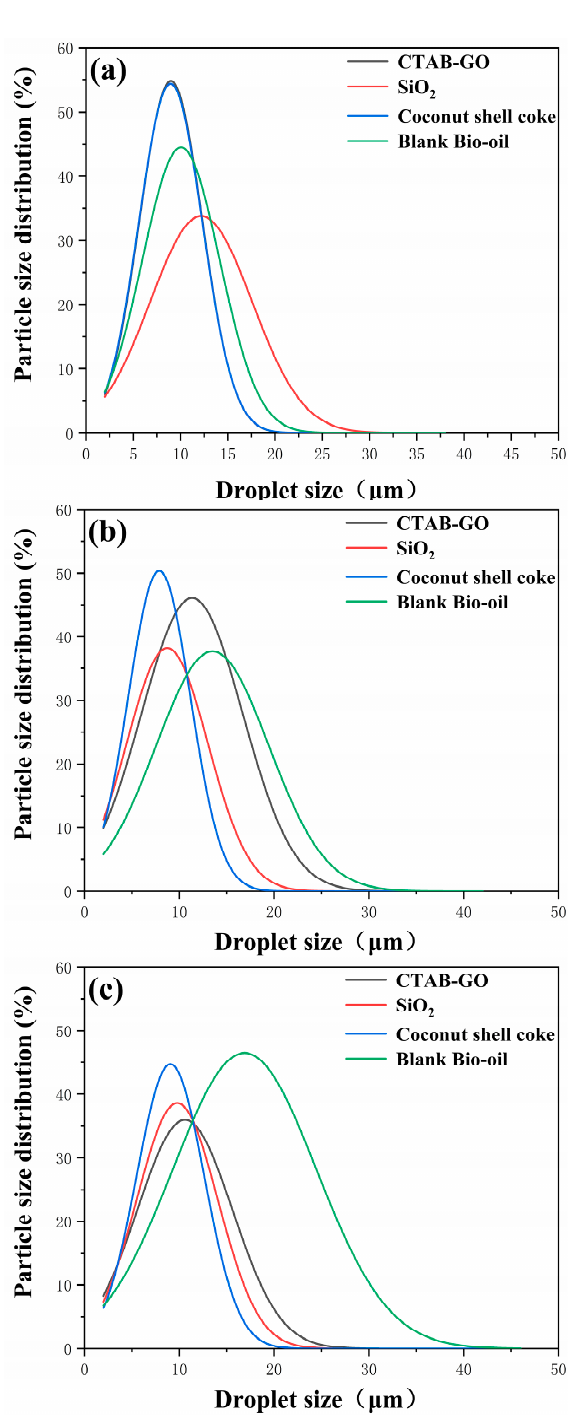
Figure 6. Droplet size distribution of Pickering emulsion and blank emulsion of bio-oil stabilized by three kinds of solid particles. ( a ) Day 1, ( b ) Day 5, ( c ) Day 21.